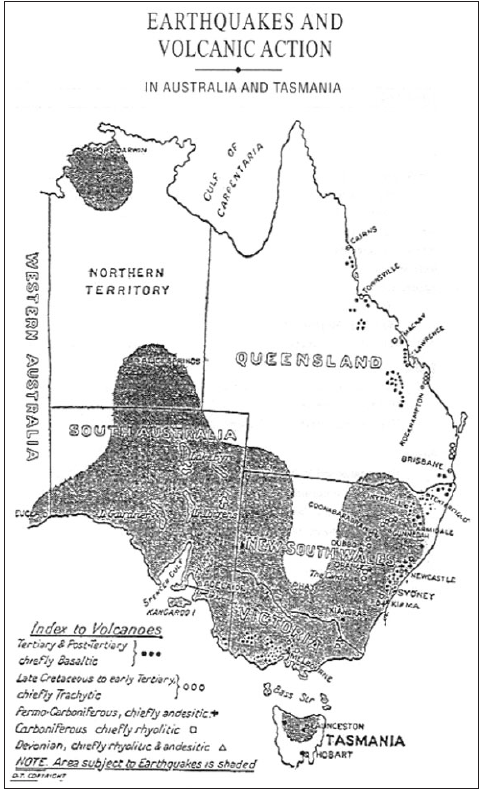
Fig. 1. A 1902 Daily Telegraph newspaper map of earthquakes in Eastern Australia compiled by Edge- worth